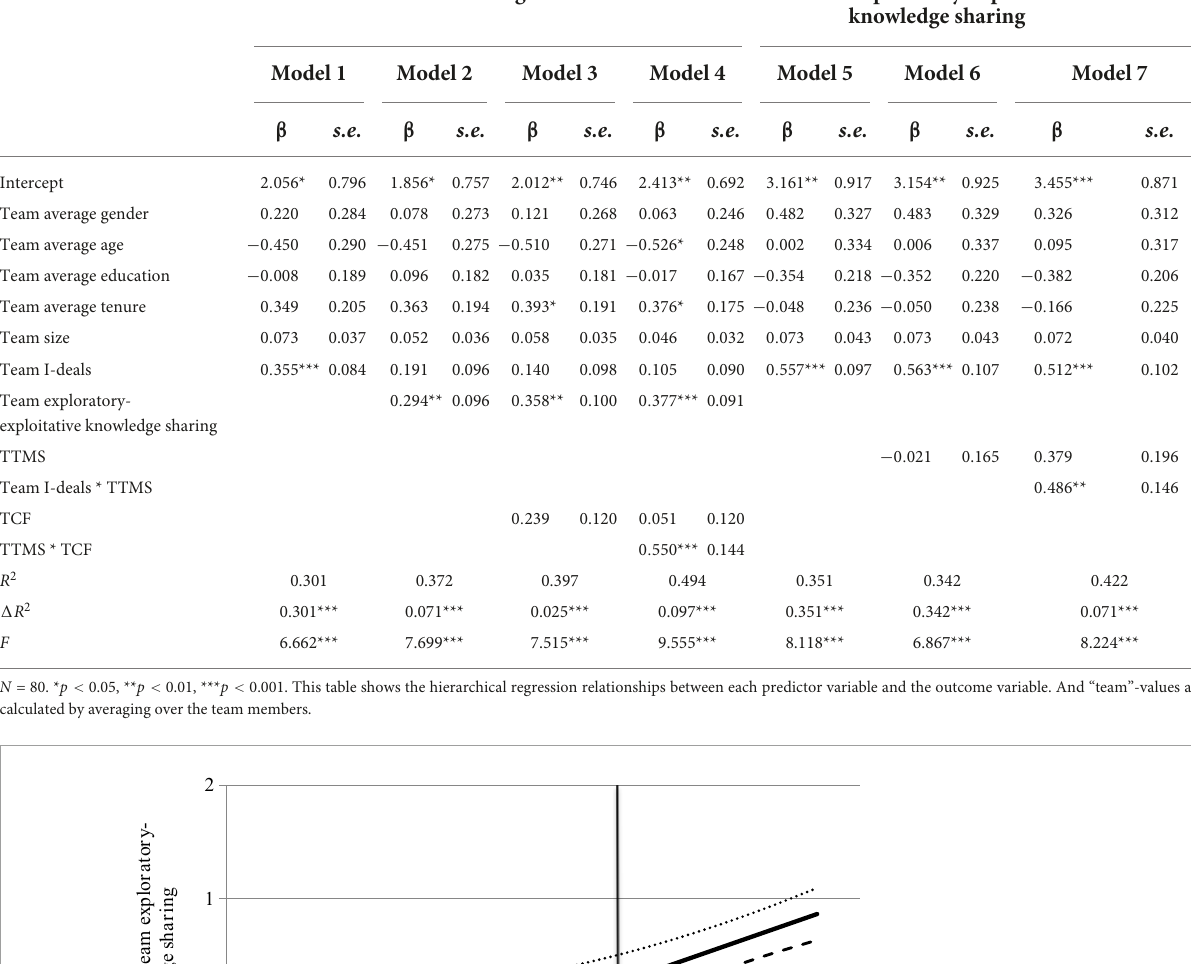
TABLE 2 Hierarchical regression results.